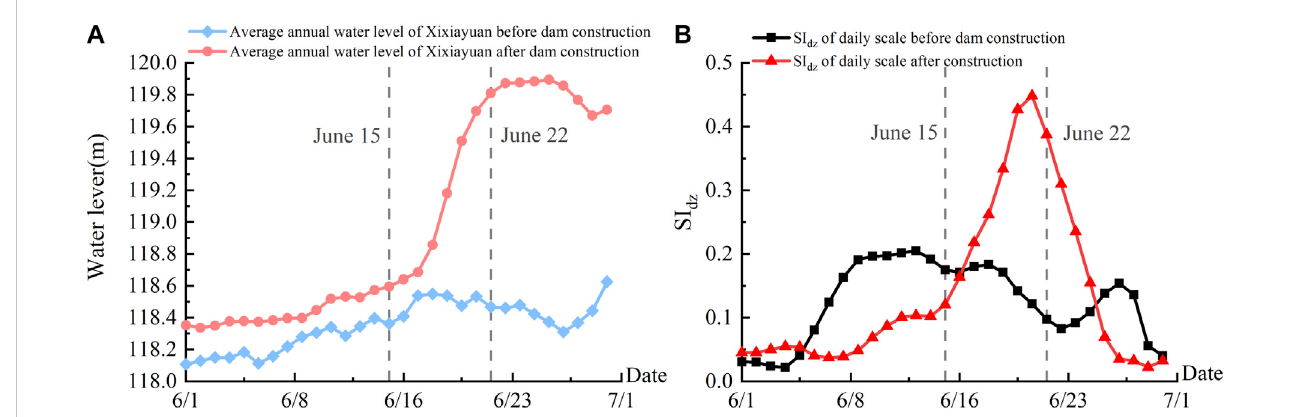
FIGURE 7 SimulatedaveragewaterleveloftheXixiayuanHydrologicalStationovertheyearsandthedaily-scalewater-levelriseindex ( SI dz )